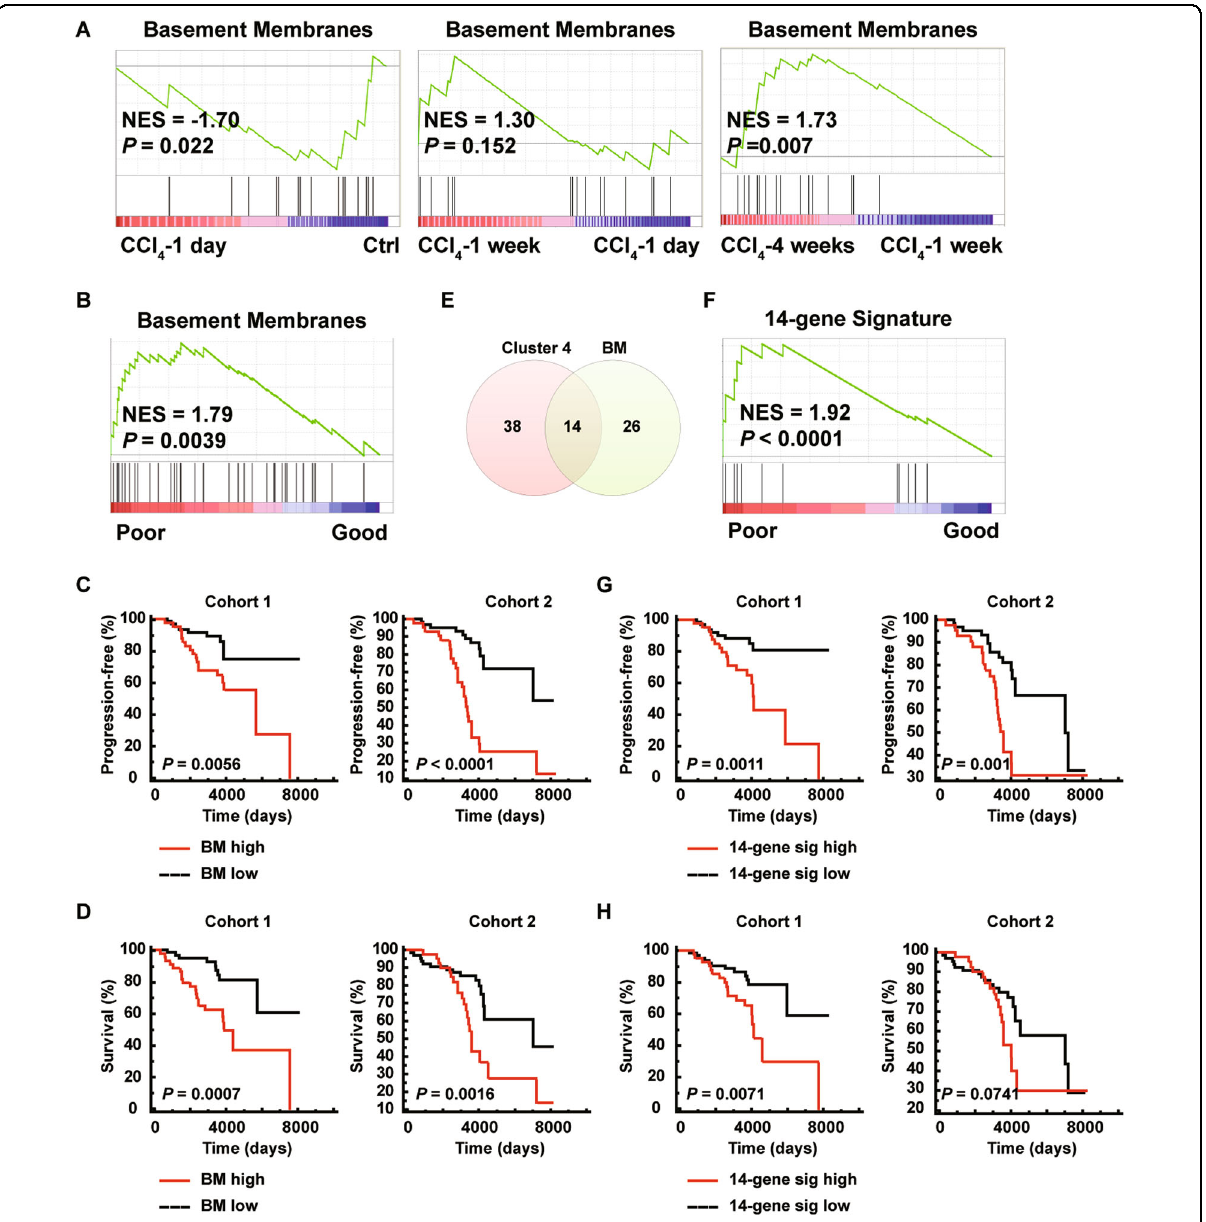
Fig. 3 Basement membrane proteins are dynamically deposited in CCl 4 -induced liver fi brosis, and predict disease progression and survival of early-stage liver cirrhosis patients. A GSEA analyses comparing enrichment of core basement membrane signature in hepatic matrices across four liver fi brogenesis stages. B GSEA analyses comparing enrichment of core basement membrane signature between good prognosis and poor prognosis Child-Pugh Class A early-stage liver cirrhosis biopsies. C , D Probabilities of disease progression from Child-Pugh Class A to Class B or C ( C ) and survival ( D ) of early-stage cirrhosis patients according to the expression level of the core basement membrane signature. E Venn diagram depicting overlap of cluster-4 signature and basement membrane signature. F GSEA analyses comparing enrichment of 14-gene signature between good prognosis and poor prognosis Child-Pugh Class A early-stage liver cirrhosis biopsies. G , H Probabilities of disease progression from Child-Pugh Class A to Class B or C ( G ) and survival ( H ) of early-stage cirrhosis patients according to the expression level of the 14-gene